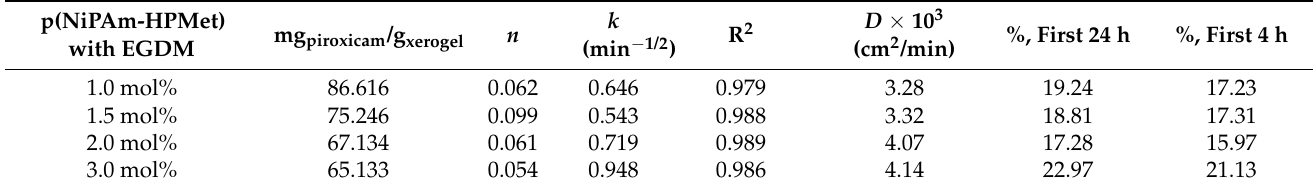
Table 9. Kinetic parameters of diffusion ( n , k and D ) for piroxicam released from p(NiPAm-HPMet) copolymers at 37 ◦ C and pH